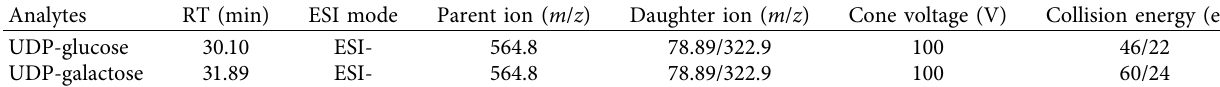
Table 1: The MS parameters of UDP-glucose and UDP-galactose.